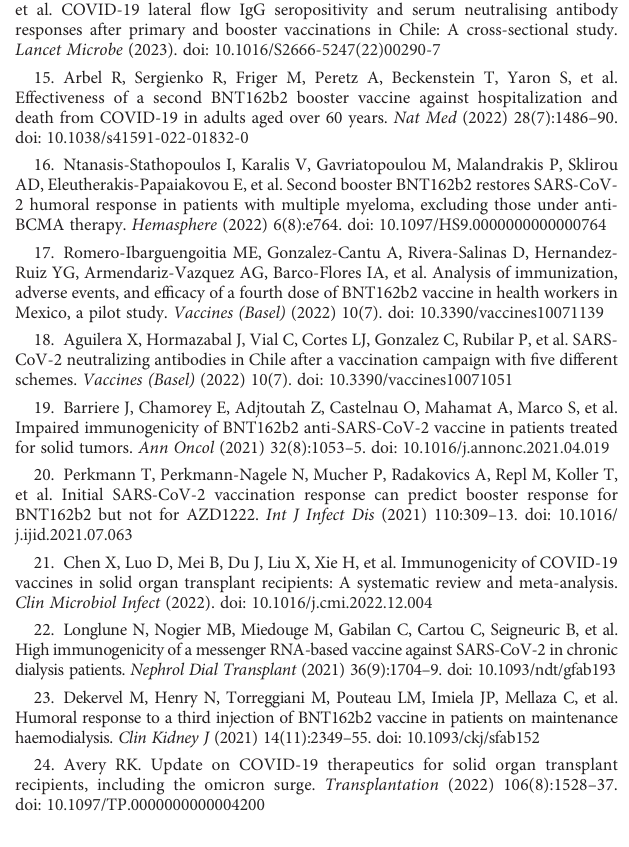
(pVNT 50 , con fi dence intervals and R 2 ), ELISA anti-Spike and anti-N as well as OnSite rapid test of serums at 90 days after the initial vaccination scheme (columns I-S), after the fi rst booster (columns U-AF) and after the second